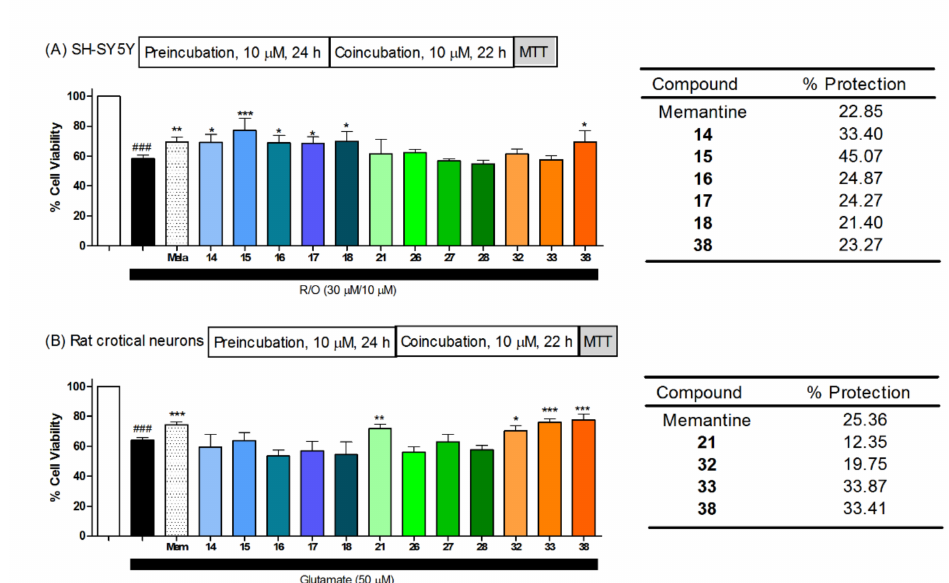
Figure 5. Effect of compounds on cell viability compromised by rotenone and oligomycin A (R/O) in SH-SY5Y cells ( A ) or glutamate 50 µ M in rat cortical neurons ( B ) measured by the MTT method. Data are means ± SEM of at least three independent experiments in triplicate, normalized over the maximum viability (control) obtained from cells not exposed to the toxic stimulus. Melatonin (Mela, 10 nM) or memantine (Mem, 30 nM) were used as standard compounds, respectively. ### p < 0.001, compared with control group (white bars), *** p < 0.001, ** p < 0.01, * p < 0.05 compared with cells stimulated with toxic stimulus in absence of compounds (black